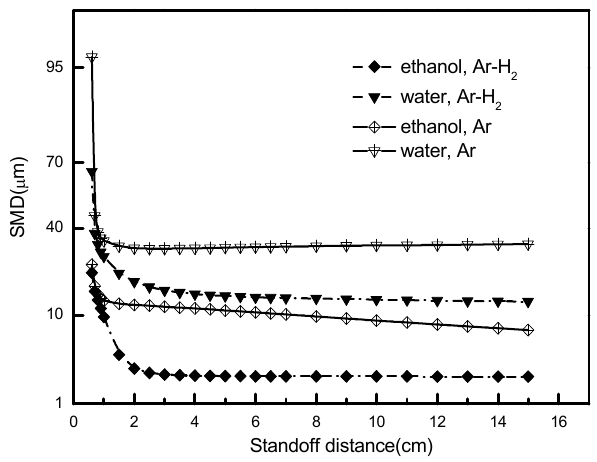
Figure 8. Droplet Sauter mean diameter in the Ar or Ar-H 2 plasma gas.